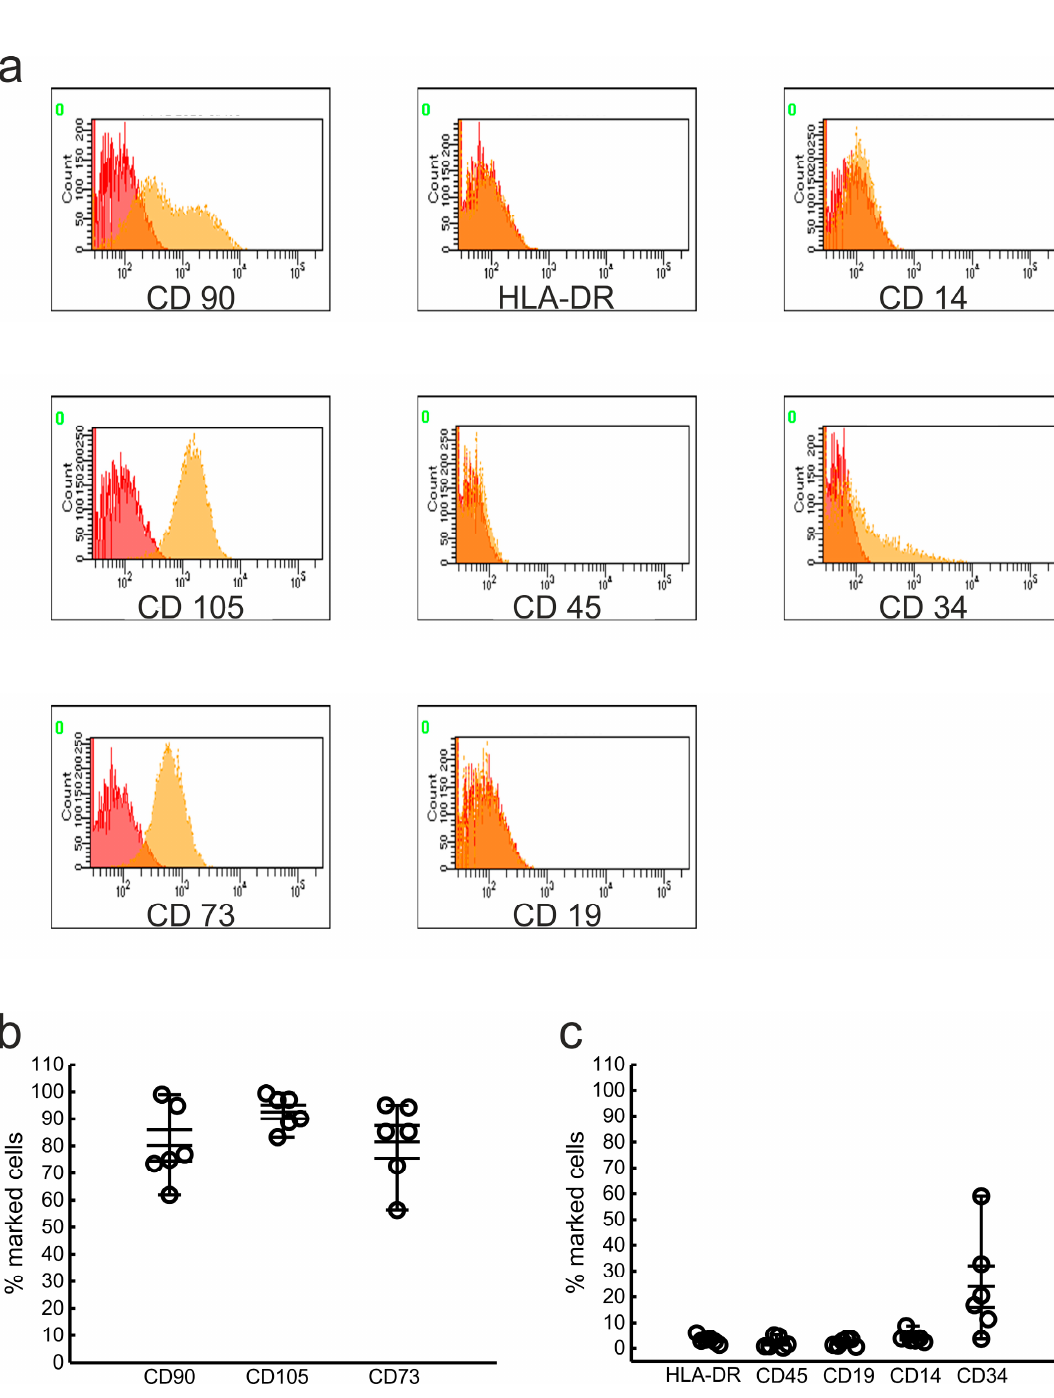
Figure 3. Immunophenotypic characterization of the cellular fraction isolated using IStemRewind from lipoaspirates. ( a ) Representative flow cytometry histograms of the indicated surface markers in cells from one IStemRewind isolate. Histograms indicate stained cells (yellow) over their respective isotypic control (red). ( b , c ) Box plots of the percentage of cells extracted from different lipoaspirates ( n = 6) stained for mesenchymal markers (CD 90, CD 105 and CD 73, ( b )) and hematopoietic markers (HLA-DR, CD 45, CD 19, CD 14, CD 34, ( c )).